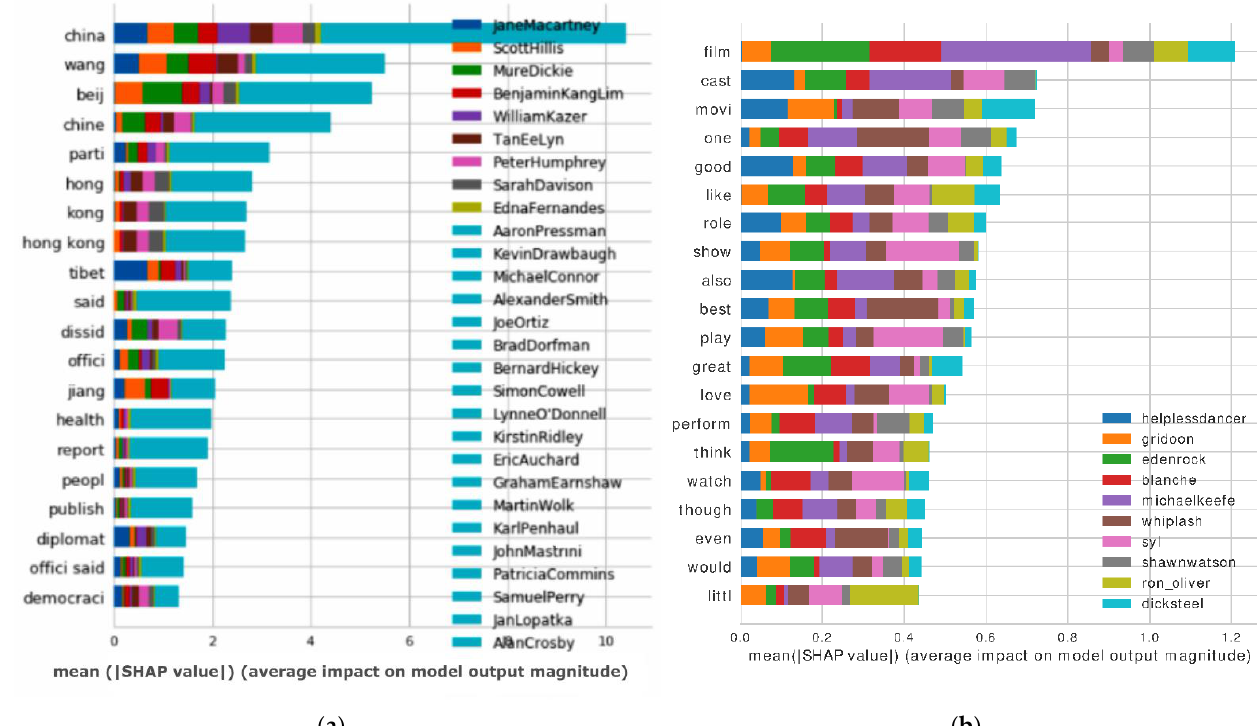
Figure 12. SHAP summary plots for ( a ) CCAT50 dataset, and ( b ) IMDB62